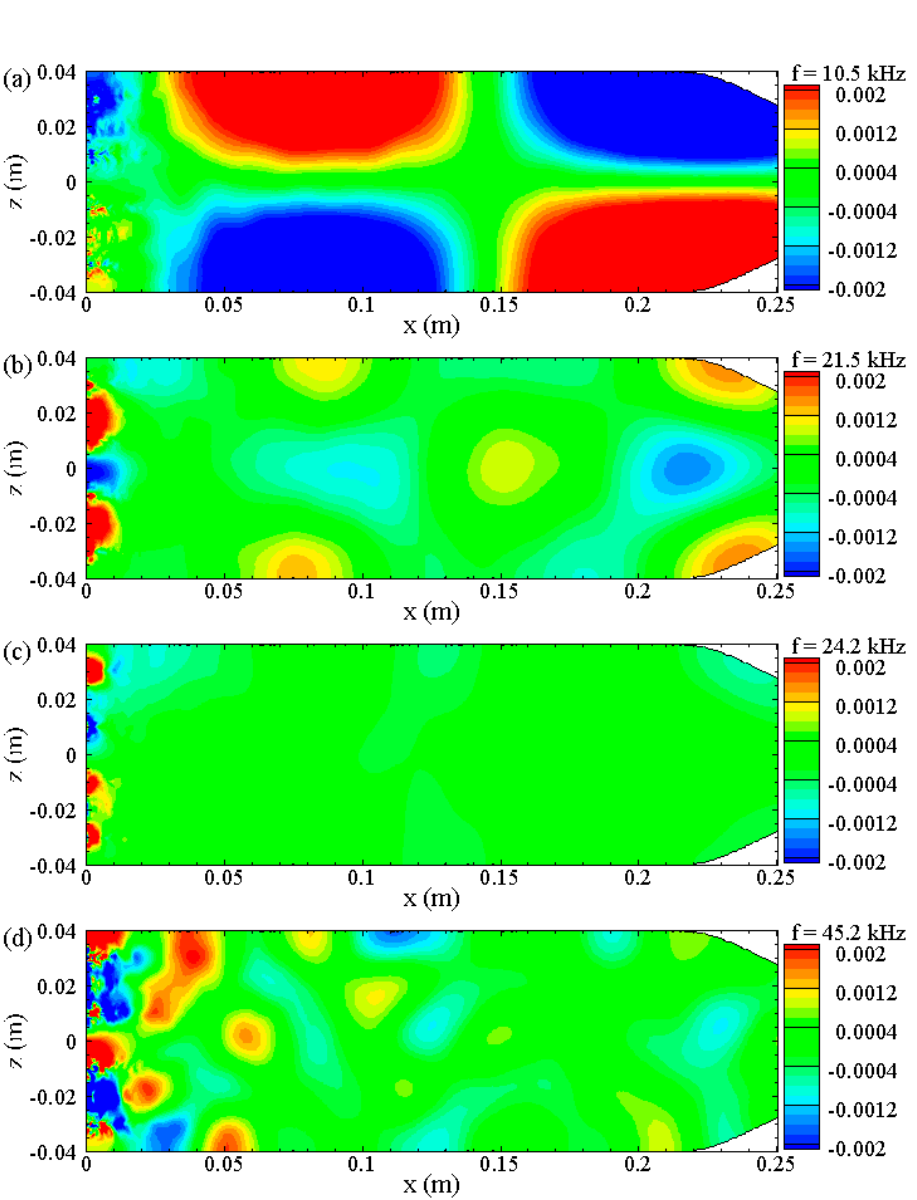
Figure 12. Resonant modes decomposed from the DMD method, ( a ) unstable 1st transverse mode ( f = 10.5 kHz), ( b ) un- stable 1st and 2nd radial modes ( f = 21.5 kHz), ( c ) unstable 2nd radial mode ( f = 24.2 kHz), ( d ) unstable 2nd radial mode ( f mode ( f = 10.5 kHz), ( b ) unstable 1st and 2nd radial modes ( f = 21.5 kHz), ( c ) unstable 2nd radial = 45.2 kHz). mode ( f = 24.2 kHz), ( d ) unstable 2nd radial mode ( f = 45.2